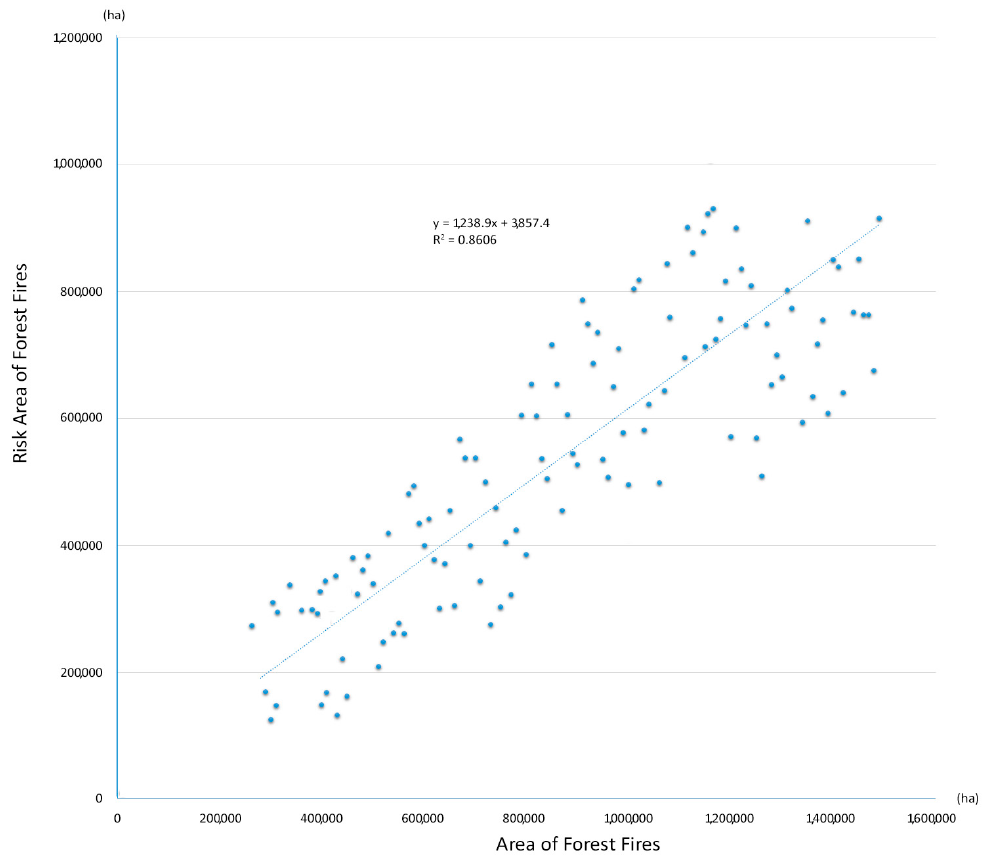
Figure 9. Correlation between the forecasted forest fire risk area and the actual forest fire area.